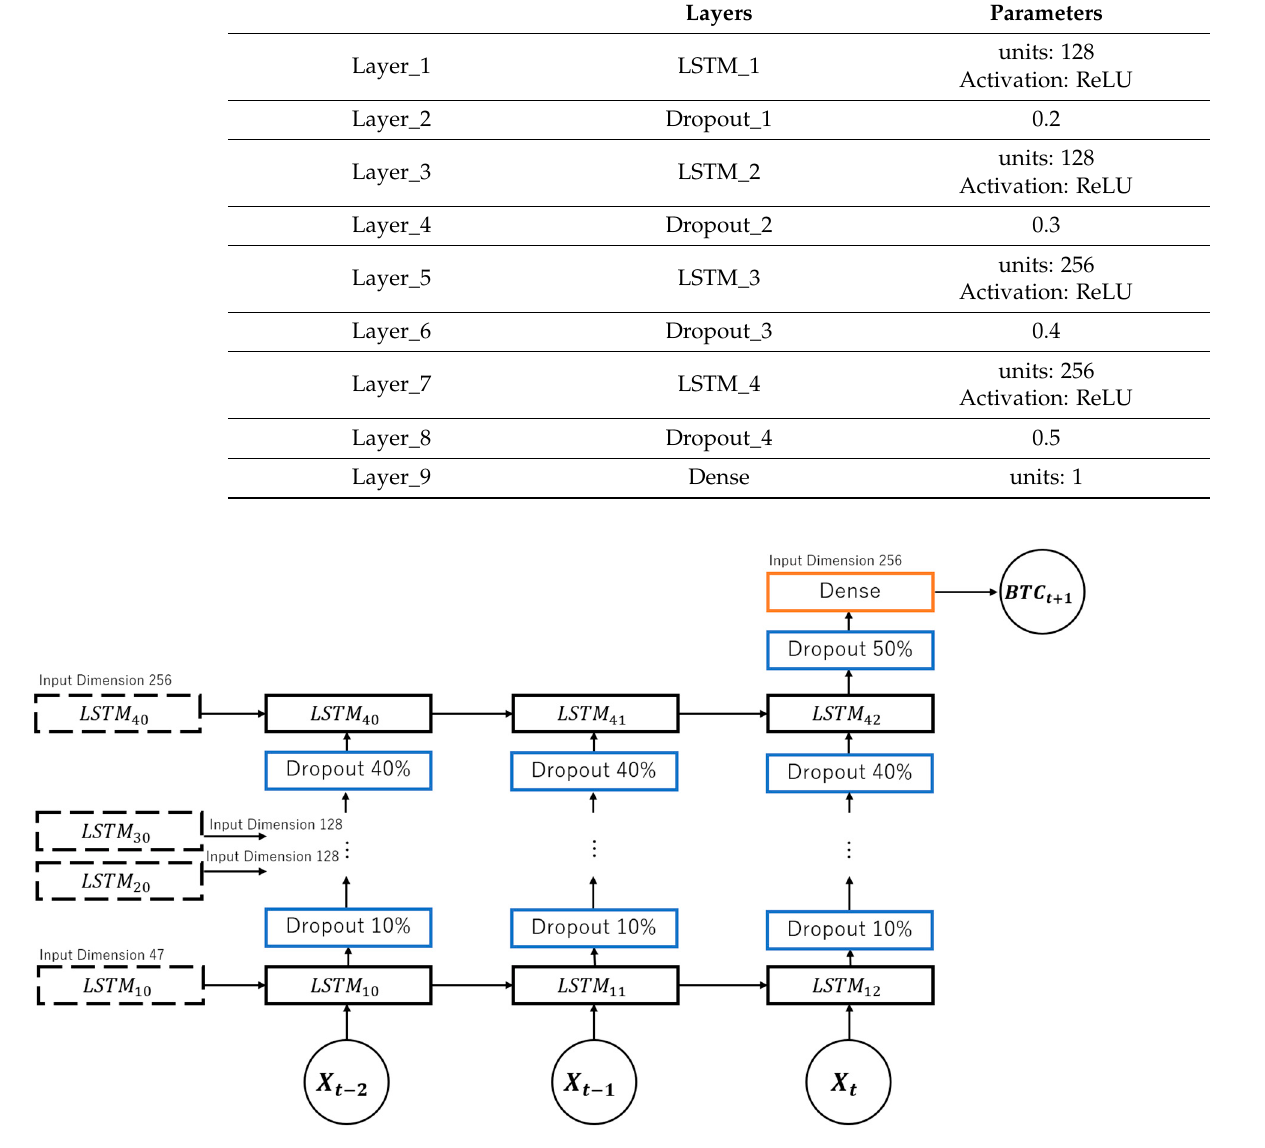
Figure 2. Parameters and framework of LSTM.